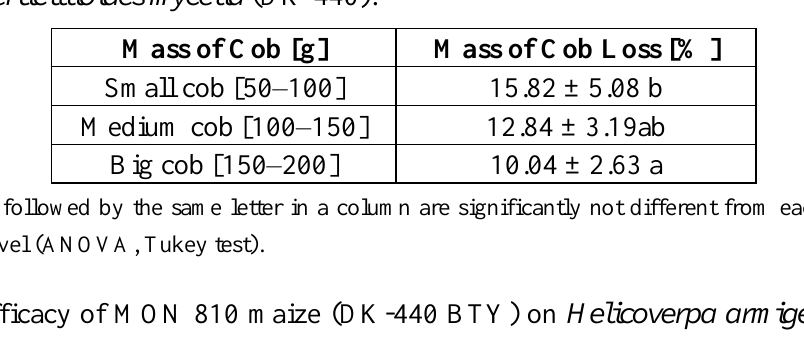
Table 6. Cob loss by apical cob damage caused by Helicoverpa armigera larvae and Fusarium verticillioides mycelia (DK-440).